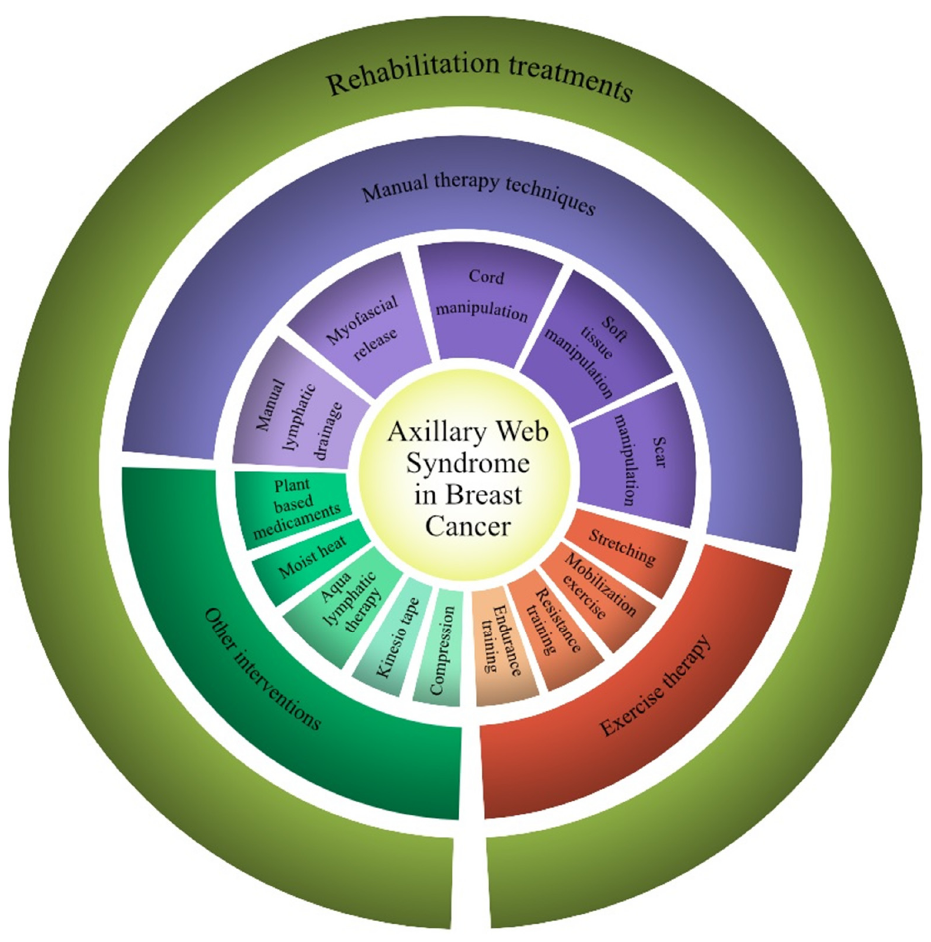
Figure 2. Rehabilitation therapy interventions for axillary web syndrome proposed in this systematic review.